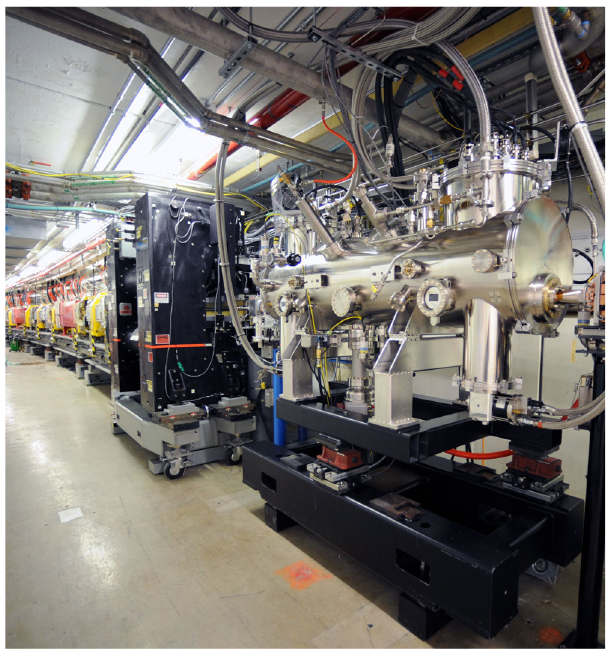
FIG. 1. Helical superconducting undulator installation on the APS storage